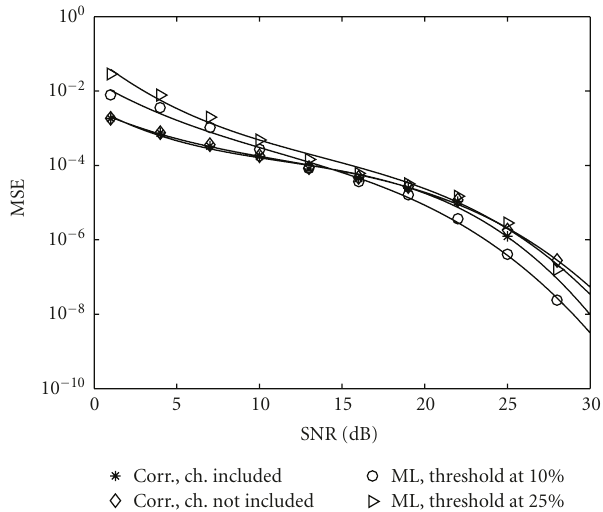
Figure 8: Residual CFO of the proposed long preamble-based carrier acquisition methods. The vertical axis show the MSE of residual CFO normalized to the subcarrier spacing of the payload. The horizontal axis indicates the SNR during the payload part of the